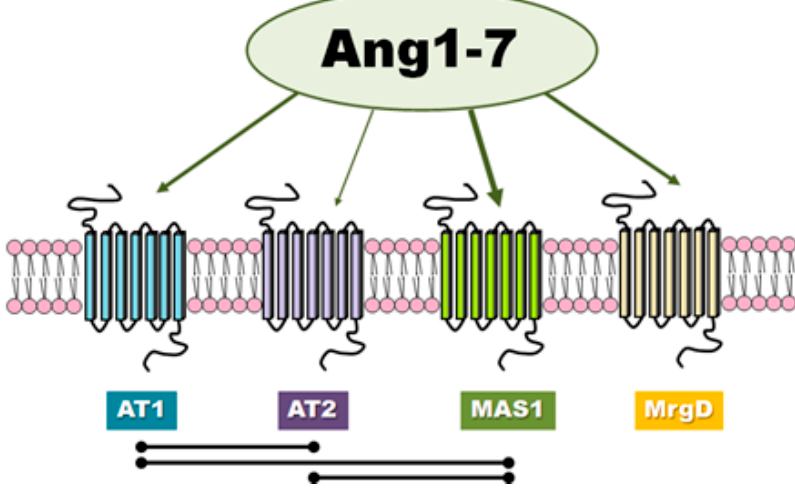
Figure 2. The receptors involved in Ang-(1-7) activity and the mutual interactions between